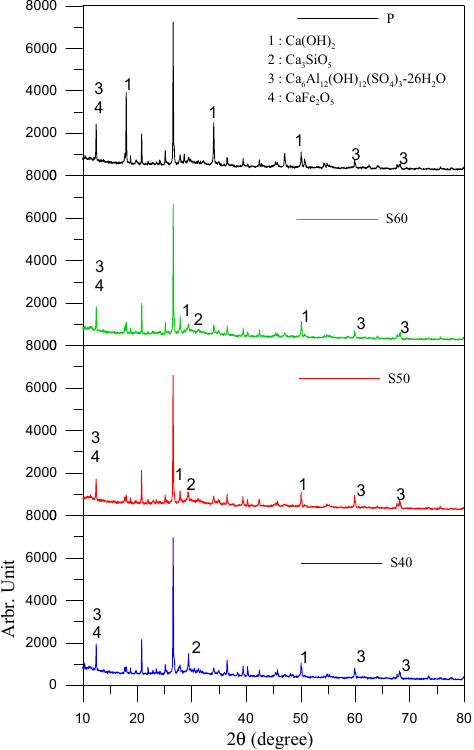
Figure 8. XRD patterns of various samples at 28 days.